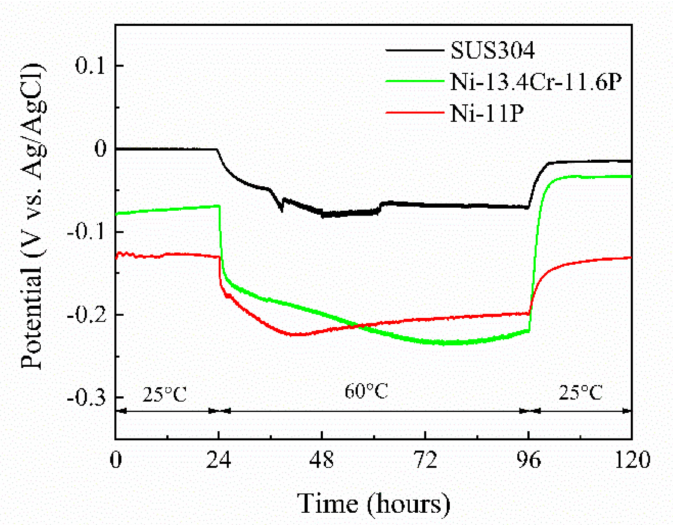
The corrected “ Figure 10. Spontaneous potentials of SUS304, brazed Ni-11P alloy coating, and brazed Ni-13.4Cr-11.6P alloy coating in 0.06 M/L NaCl aqueous solution at different temperatures. Figure 11. Current density-time curve of galvanic couples of SUS304/brazed Ni-11P alloy coating and SUS304/brazed Ni-13.4Cr-11.6P alloy coating in 0.06 M/L NaCl aqueous solution at different temperatures. ” appears below. The authors apologize for any inconvenience caused and state that the scientific conclusions are unaffected. The original article has been updated.